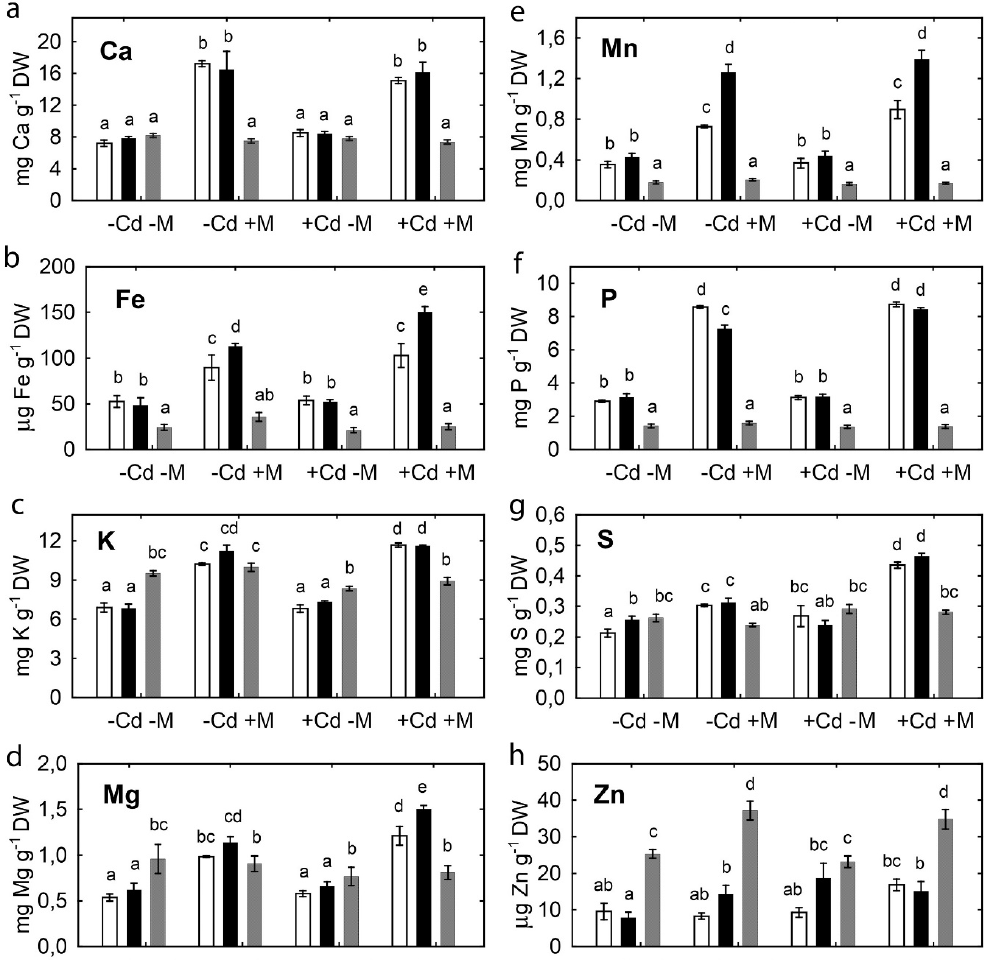
Figure 4. Calcium ( a ), iron ( b ), potassium ( c ), magnesium ( d ), manganese ( e ), phosphorus ( f ), sulfur ( g ), and zinc ( h ) in shoots of pea SGE (unfilled columns), SGECd t (filled columns), and B. juncea (gray columns) grown in uncontaminated or Cd-supplemented soil. Treatments: -Cd-M—uncontaminated soil with uninoculated plants, -Cd + M—uncontaminated soil with inoculated plants, + Cd-M—Cd-supplemented soil with uninoculated plants, + Cd + M—Cd-supplemented soil with inoculated plants. Plants were inoculated with a microbial consortium consisting of Variovorax paradoxus 5C-2, Rhizobium leguminosarum bv. viciae RCAM1066, and Glomus sp. 1Fo. Vertical bars show standard errors. Different letters show significant differences between treatments (least significant difference test, p < 0.05, n = 5). DW stands for dry weight. Plants were analyzed at the 83-rd day after